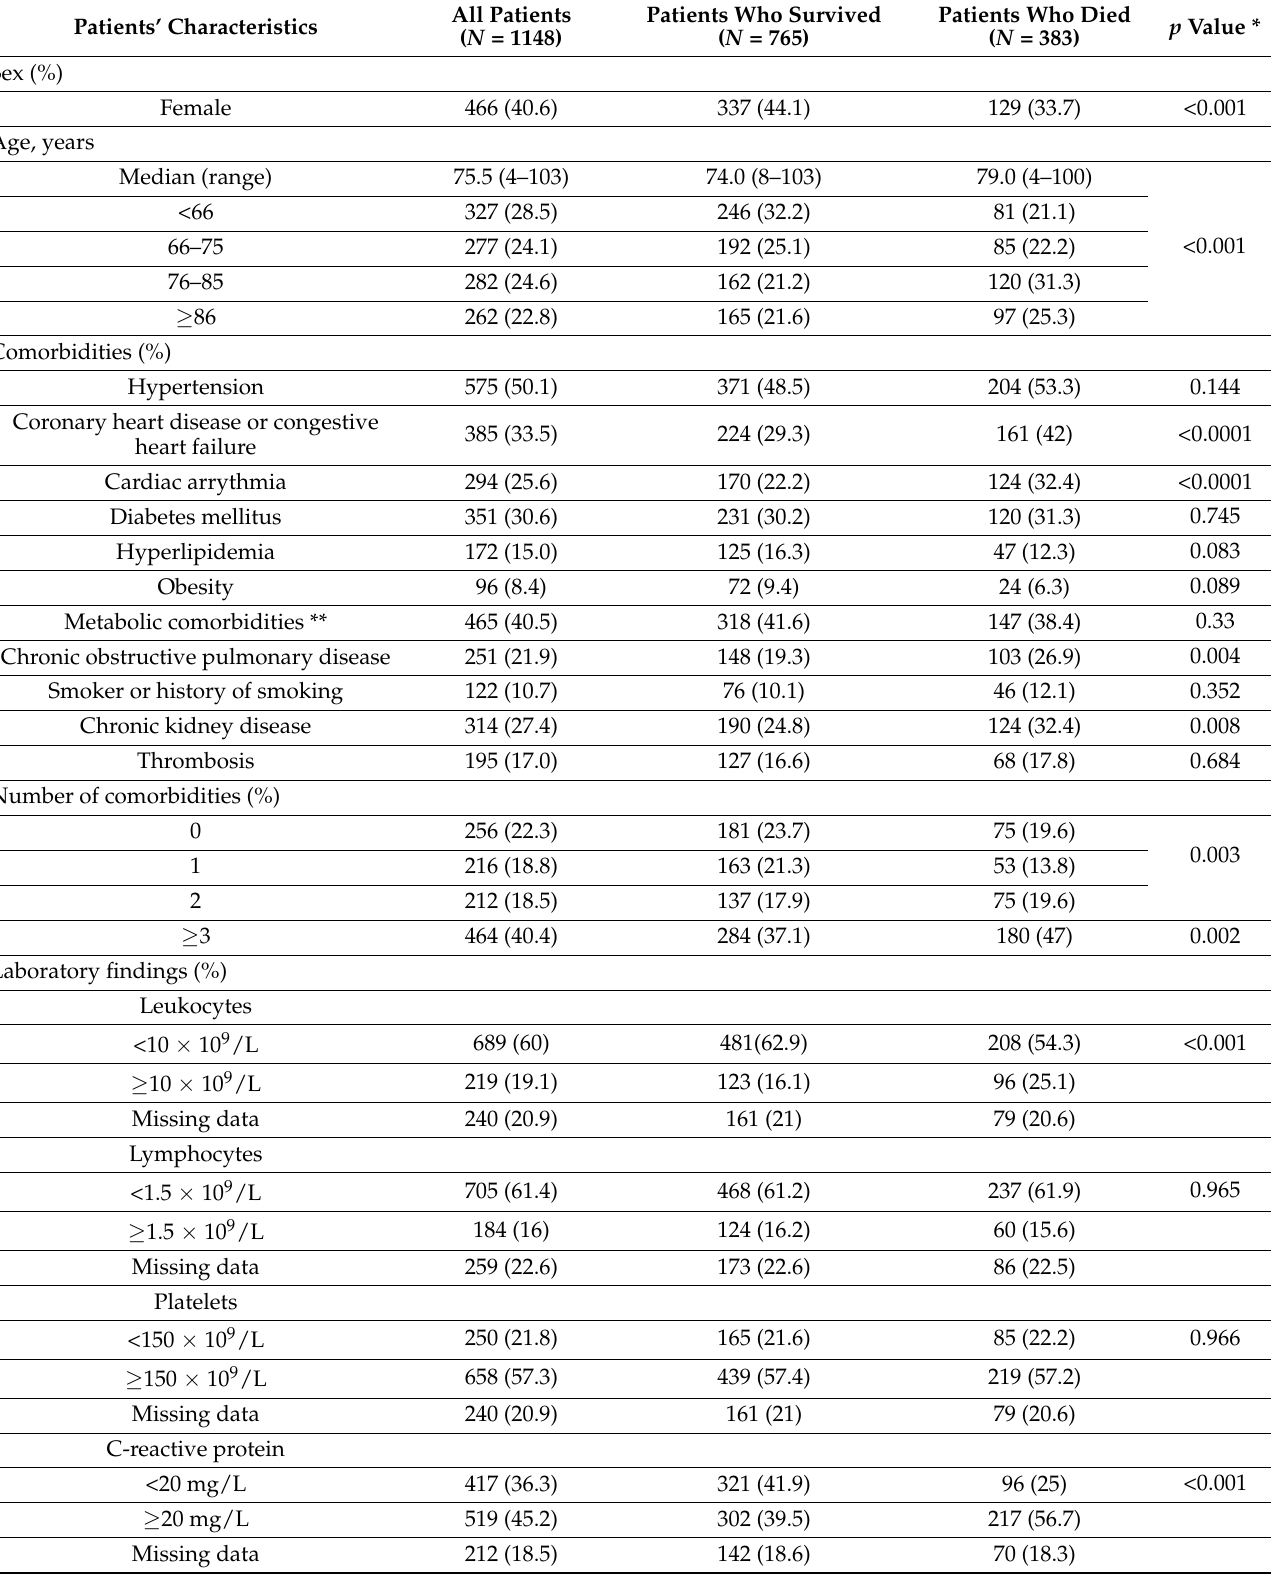
Table 1. Patients’ characteristics and coexisting conditions among cancer patients with confirmed COVID-19. * Groups were compared using Pearson chi-square or Student T test as appropriate. ** metabolic comorbidities include diabetes mellitus, hyperlipidemia or